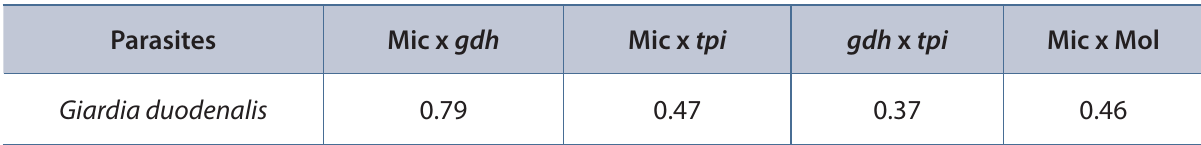
Table 4. Agreement analysis (kappa index) between microscopic and molecular methods used for the diagnosis of Giardia